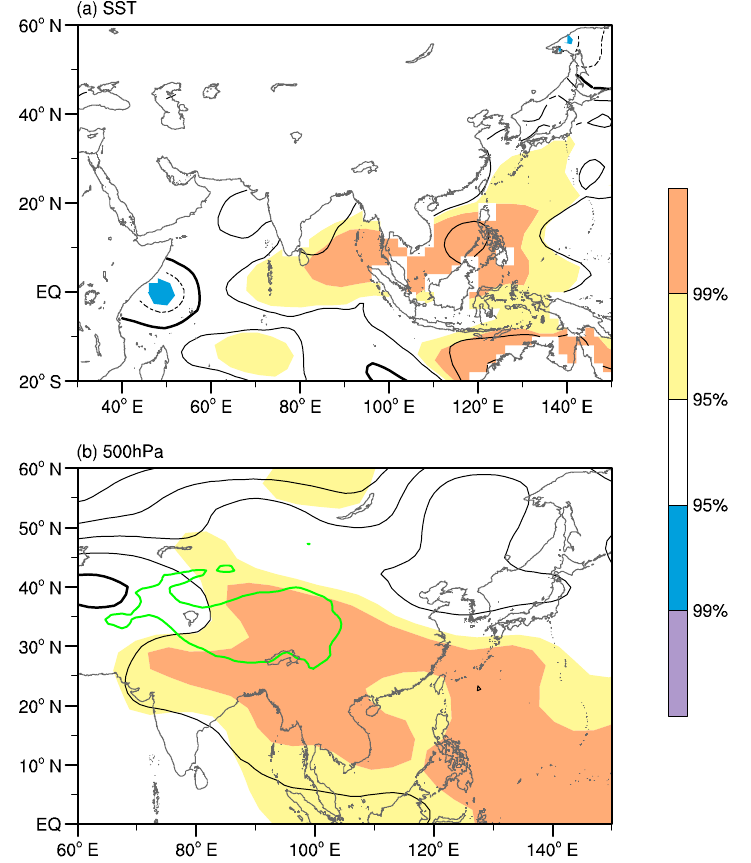
Figure 6. ( a ) Summer sea surface temperature anomalies (SSTAs) (units: °C) obtained by regression on the preceding April Indian Ocean SST index for the period 1981–2019. Contours are drawn every 0.1 °C. ( b ) As in ( a ) but for 500-hPa geopotential height anomalies (units: gpm). Contours are drawn every 4 gpm. The bold black line is zero. The solid and dash lines denote positive and negative values, respectively. Shadings denote anomalies significant at the 95% and 99% confidence levels as shown by the color bars.